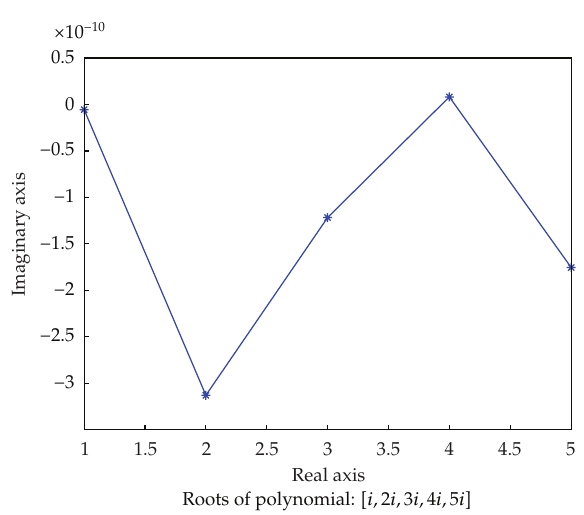
Figure 2: Error of Fiedler’s method for complex polynomial.